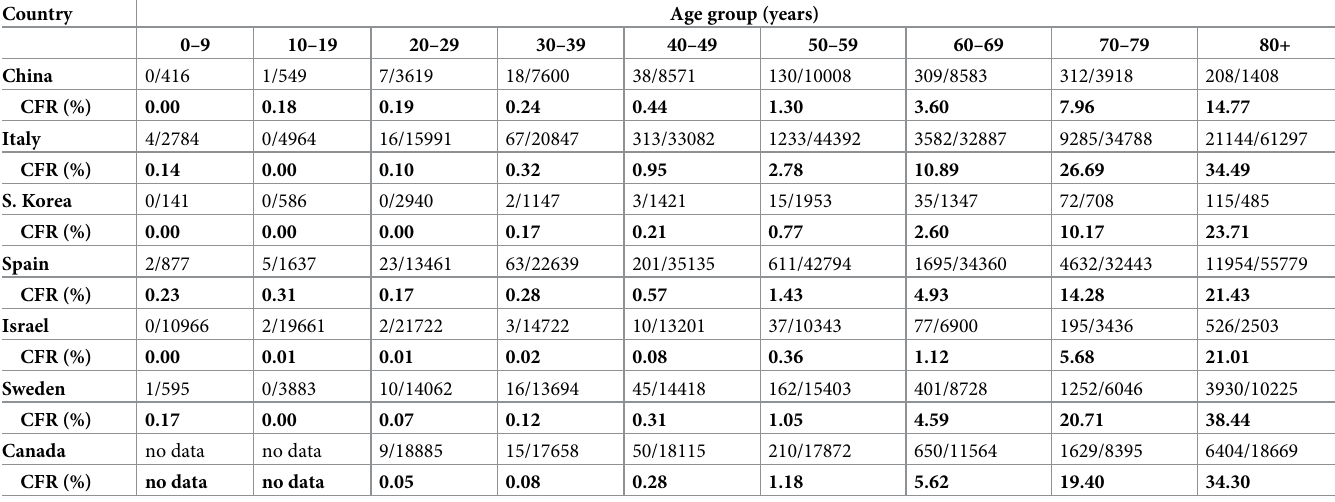
Table 1. Deaths/cases of COVID-19 and CFRs (%) by age group, for seven countries.